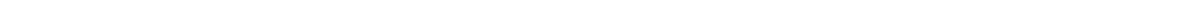
Fig. 3 Impaired γ H2AX levels in spleen B cells from CD19-cre-Usp22 KO mice. a AID mRNA measured by qPCR of d3-LPS stimulated spleen B cells from CD19-cre-Usp22 KO or WT littermates (left panel; n = 5 mice per group). AID blot analysis of d3-LPS stimulated spleen B cells from Mb1-cre or CD19-cre Usp22 KO or their WT littermates (right panel; n = 2 – 3 mice per group); AID-KO cells were used as control and data represent two or three independent experiments. b Spleen B cells from CD19-cre-Usp22 KO and WT littermates were stimulated for IgG3 CSR (by LPS) or for IgA CSR (by LPS + IL-4 + TGF- β + IL-5 + anti-IgD dextran) for 2.5 days, exposed to γ -radiation, and then collected for γ H2AX immuno fl uorescent staining. Line within micrograph represents 10 μ m. The number of γ H2AX foci per cell was analyzed 1 or 4 h post irradiation for Usp22-WT (black circles) and CD19-cre-Usp22-KO (white circles) (bottom panel), and representative images for IgG3-CSR group ( γ H2AX in green and DAPI in blue) are shown in the top panel. Approximately 30 – 50 cells were analyzed per sample and data represent two or three independent experiments. c Representative fl ow cytometry plots (left panel) and compiled cell cycle analysis (right panel) of Usp22-WT and CD19-cre-Usp22-KO spleen B cells. Cells were stimulated with LPS for 2.5 days and then incubated with EdU for 4 h, before FACS staining ( n = 3 samples per group). d Puri fi ed splenic B cells from CD19-cre Usp22-KO or WT littermates was stimulated with LPS and growth of these cells was monitored over time ( n = 3 samples per group). Data were tested by two-way ANOVA. e CFSE-pulsed spleen B cells from CD19- cre-Usp22 KO or WT littermates were stimulated by LPS plus IL-4 for CSR to IgG1 for 4 days. The gating (G2 to G11) is based on the intensity of CFSE and the percentage of IgG1 switch per gate is summarized ( n = 3 samples per group). Data in c – e represent two independent experiments; data in a – c and e were analyzed using two-tailed unpaired Student ’ s t -test. Data were presented as mean ± SEM. * p < 0.05, ** p < 0.01, and *** p <